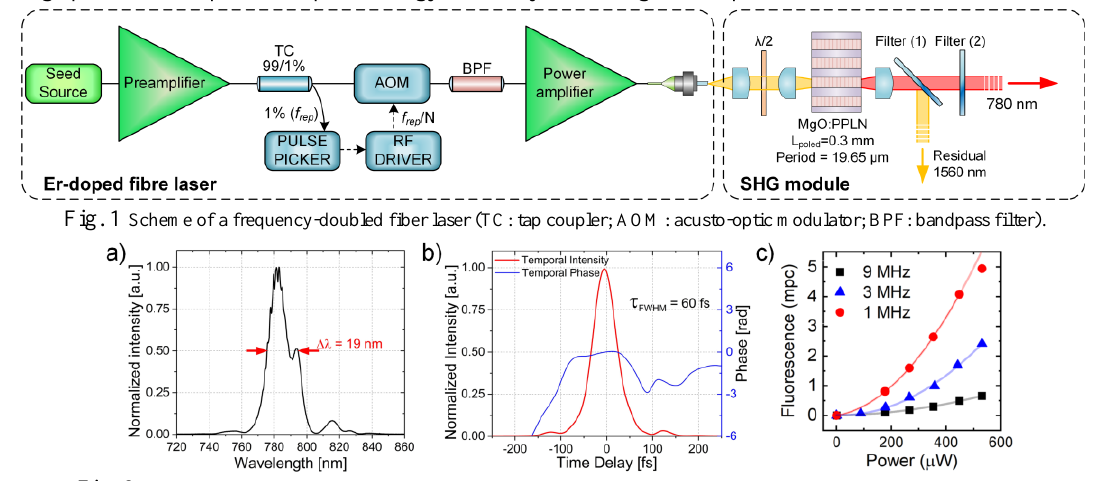
Fig. 1 Scheme of a frequency-doubled fiber laser (TC: tap coupler; AOM: acusto-optic modulator; BPF: bandpass filter).